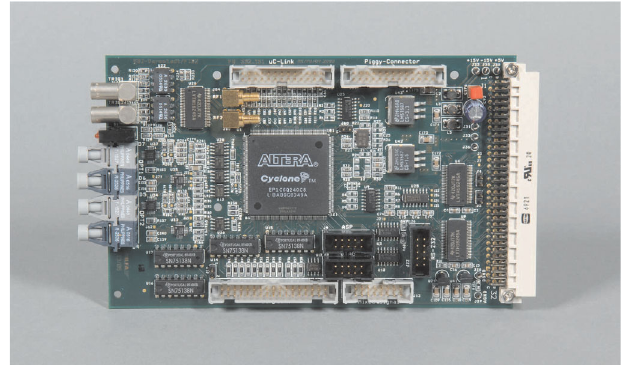
FIG. 4. FPGA interface board (FIB).